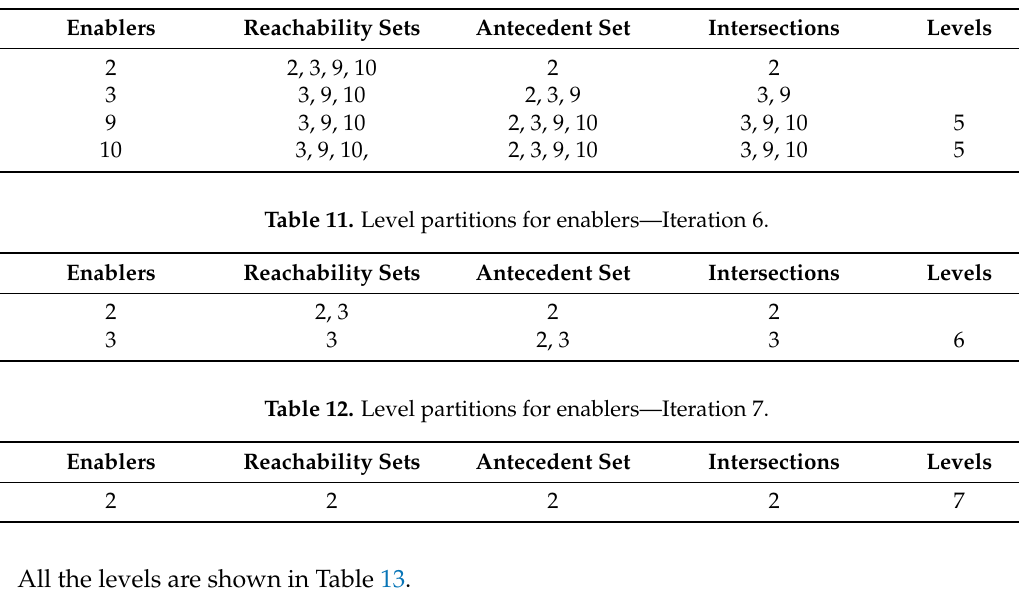
Table 10. Level partitions for enablers—Iteration 5.